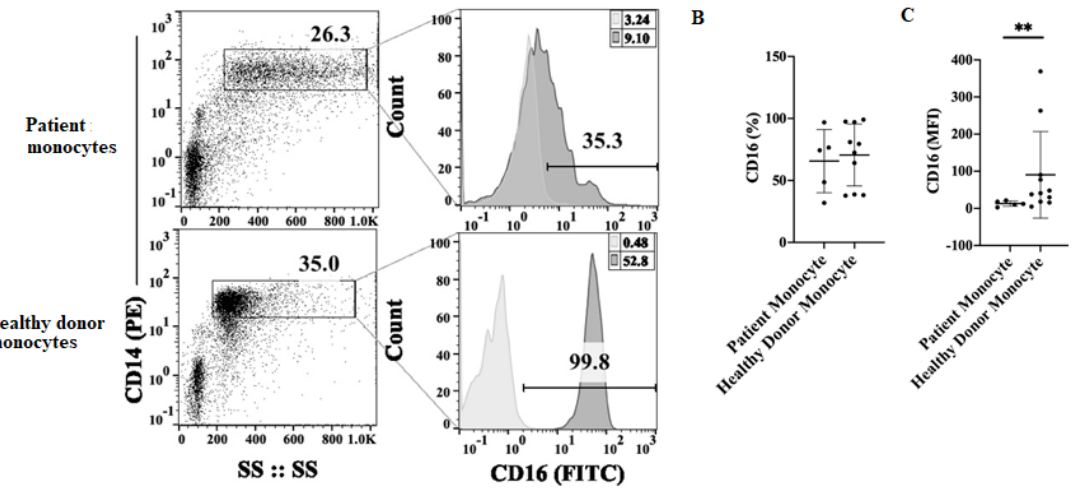
Figure 6. Monocytes obtained from cancer patients exhibited lower CD16 surface receptor expression. Monocytes of cancer patients ( n = 5) and healthy individuals ( n = 10) were isolated from PBMCs as described in Material and Methods section. Surface expression of CD16 within CD14+ population was determined using flow cytometry. One representative experiment is shown in ( A ). Compiled experiments are shown in ( B , C ), and data are presented as Mean ± SD. Student t tests were performed to determine statistical significance. ** ( p value 0.001–0.01).